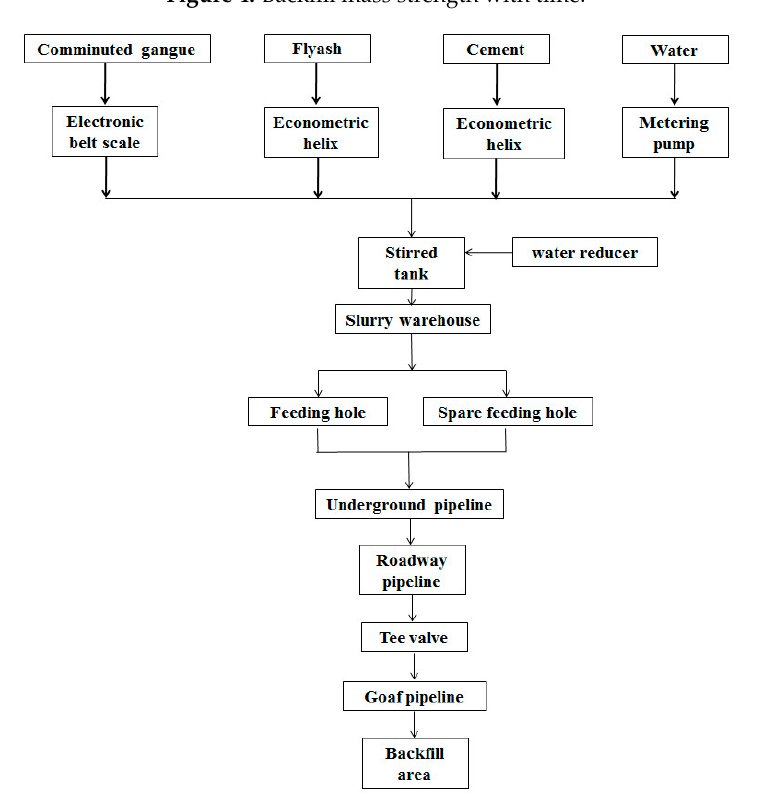
Figure 5. Diagram of the backfill material production process.